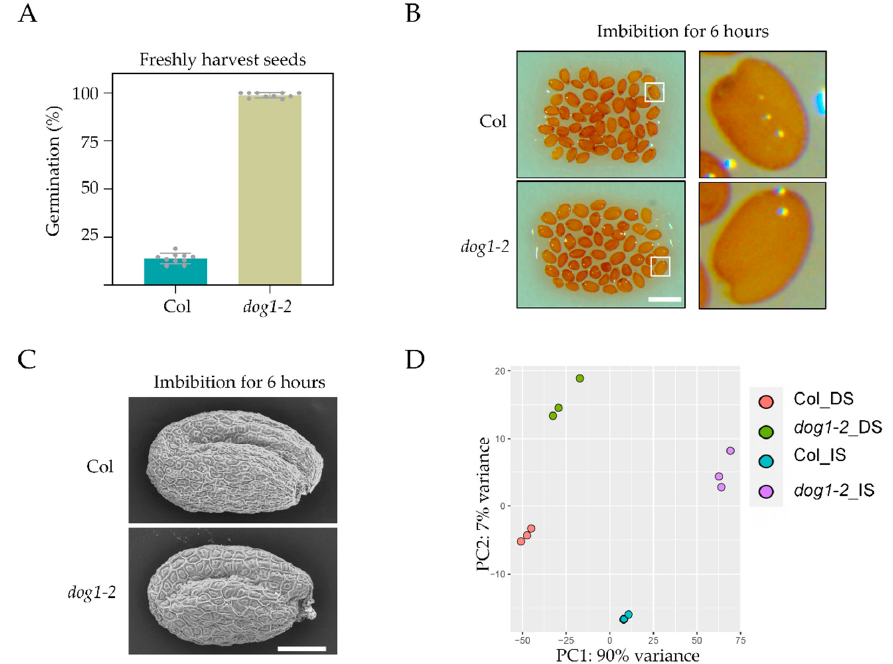
Figure 1. Quality evaluation of the experimental materials, conditions, and data. ( A ) The germination rate showed that the dog1–2 seeds completely lost dormancy. ( B ) The stereomicroscope photos showed that the germination status of the dog1–2 seeds was not changed compared with that of Col after imbibition for 6 h. ( C ) The scanning electron microscopy images showed that the surface structure of dog1–2 seeds was not changed compared with that of Col after imbibition for 6 h. ( D ) Two-dimensional Principal Component Analysis (PCA) showed that the whole transcriptome level of the dog1–2 seeds was significantly altered compared with that of the wild-type. Scale bars, 1 mm in B and 120 µ m in